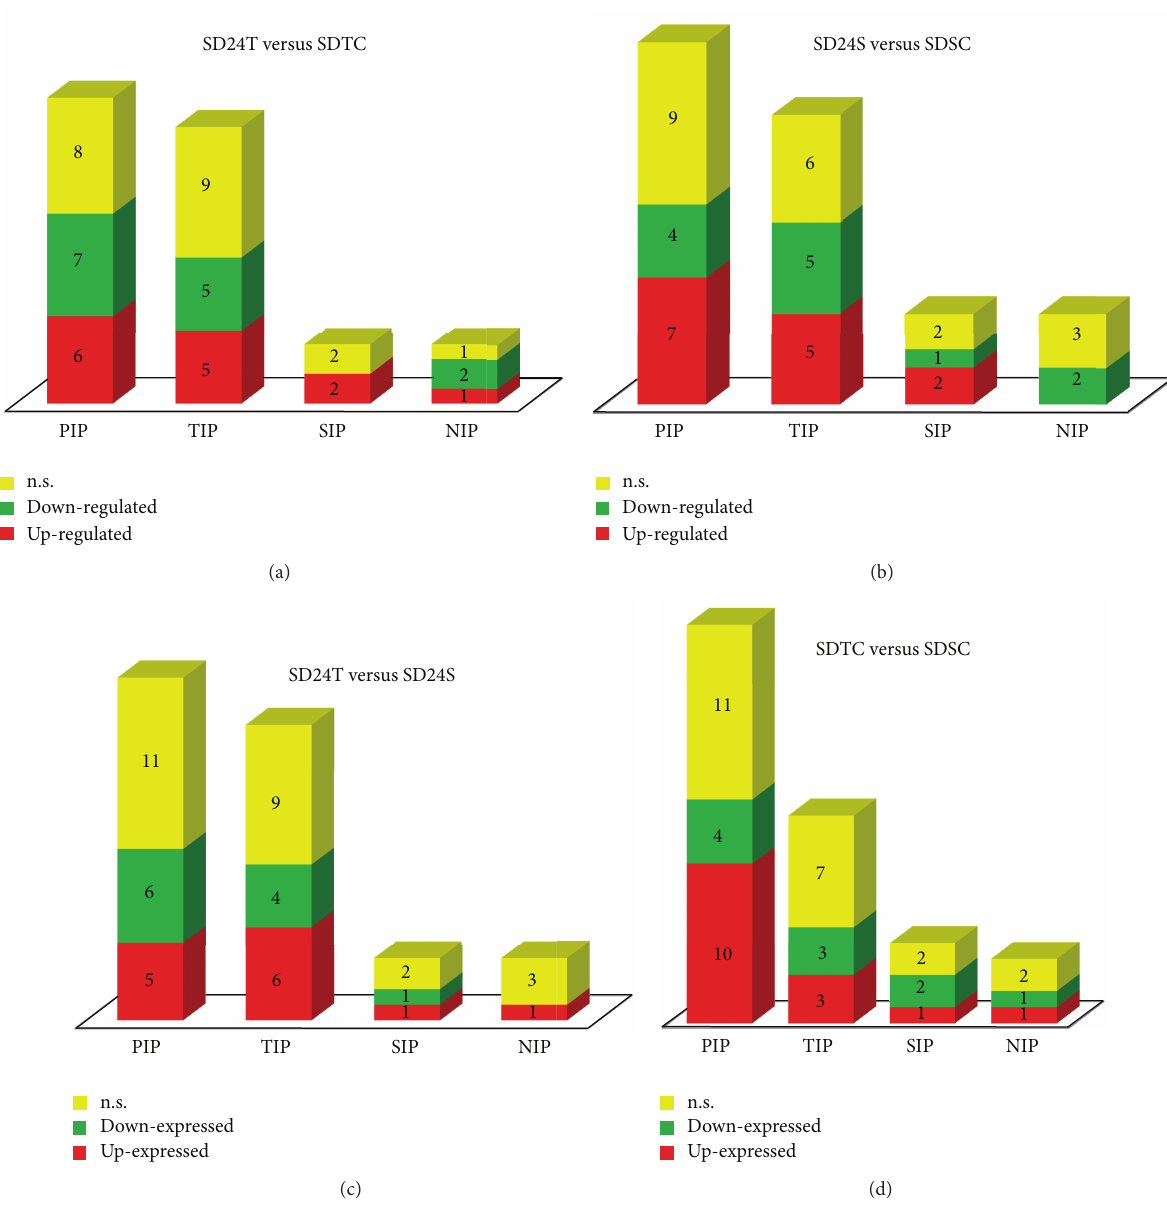
Figure 3: Representation of aquaporin subfamilies expressed in sugarcane after 24 h of continuous dehydration ((a), (b), and (c)) and during normal irrigation (d), involving bulks of genotypes tolerant and sensitive to stress. HT-SuperSAGE libraries: SD24T (bulk of tolerant genotypes under stress; SD24S (bulk of sensitive genotypes under stress); SDTC (control bulk of tolerant genotypes); SDSC (control bulk of sensitive